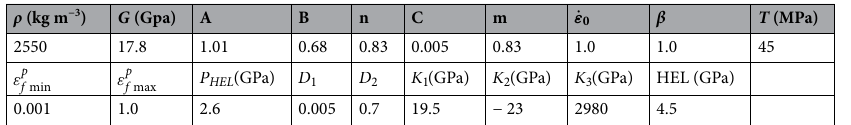
Table 2. The material parameters of the rock materials.